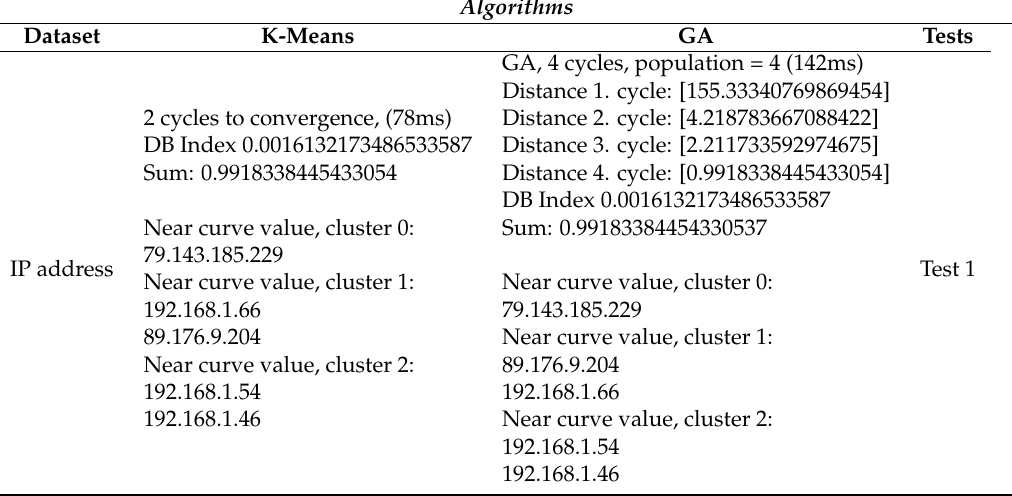
Table 7. Program outputs of the final